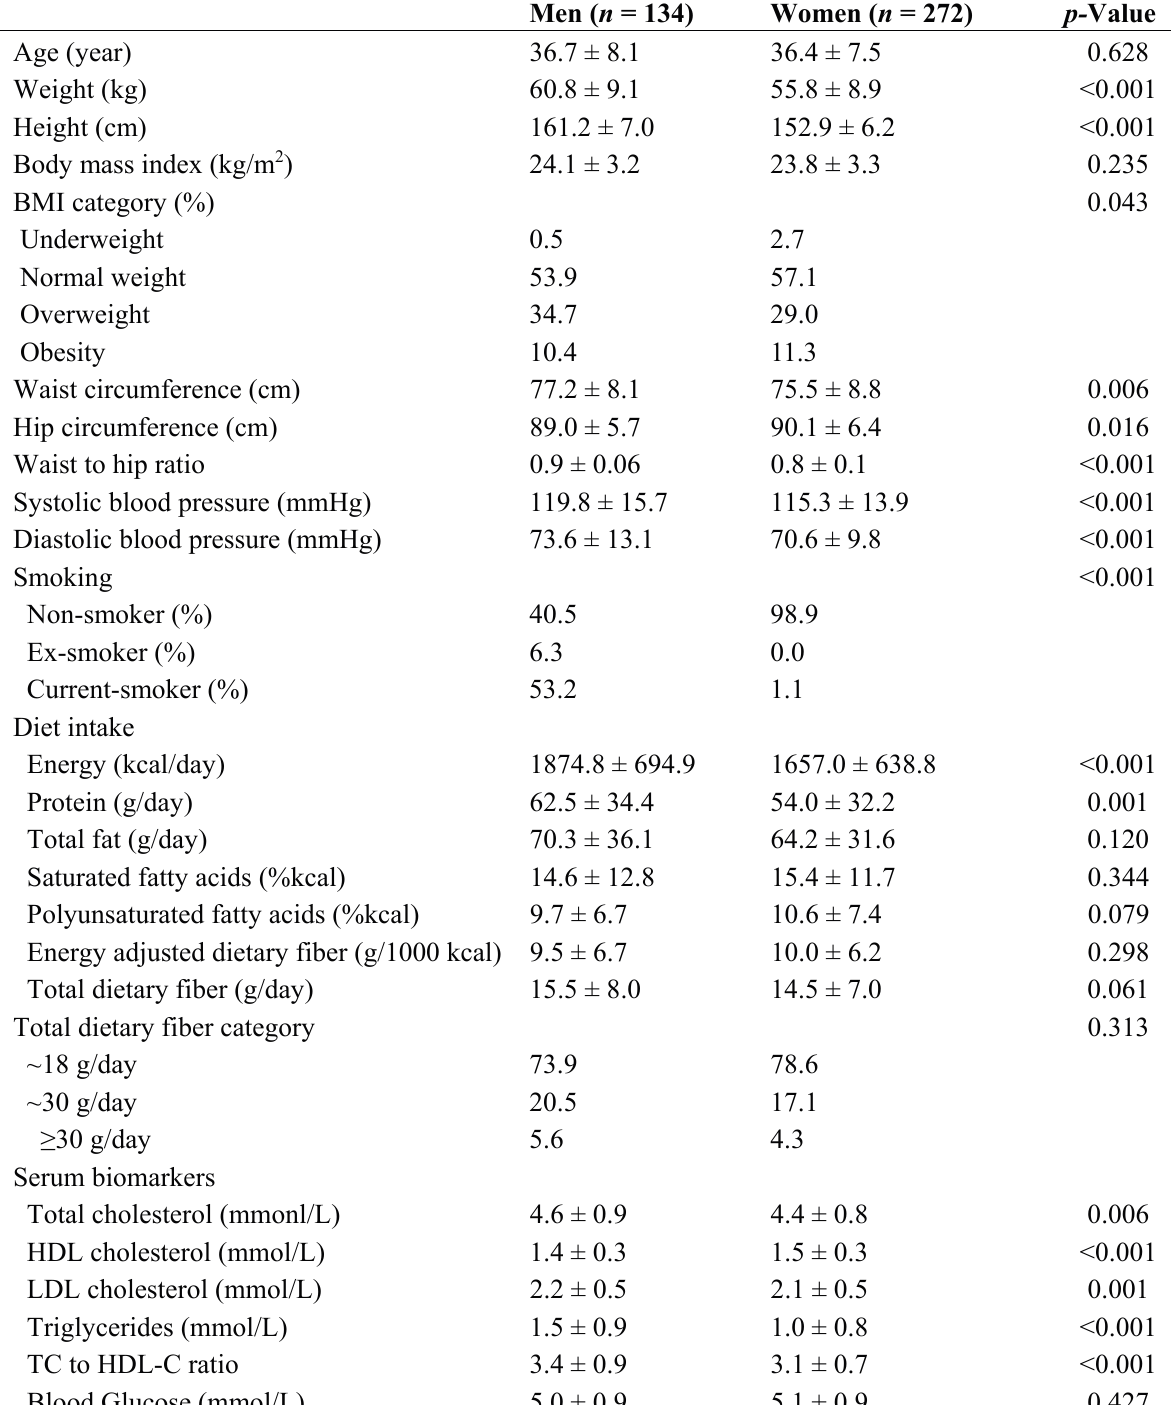
Table 1. Characteristics (mean ± S.D.) of the 1034 rural-to-urban migrant